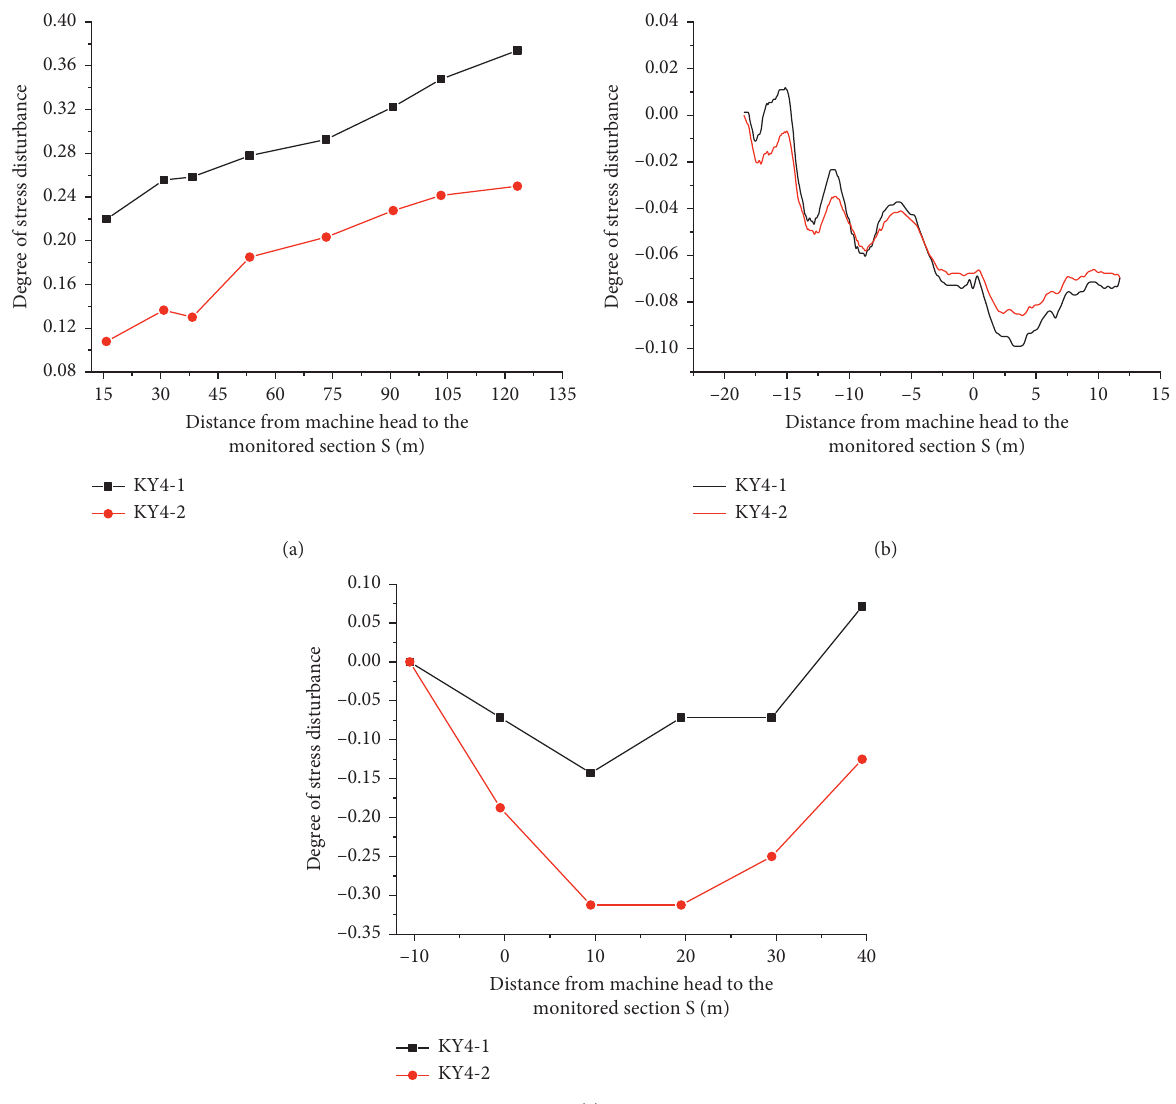
Figure 17: Degree of soil disturbance under different buried depth. (a) Hole 1 excavates. (b) Hole 3 excavates. (c) Hole 2